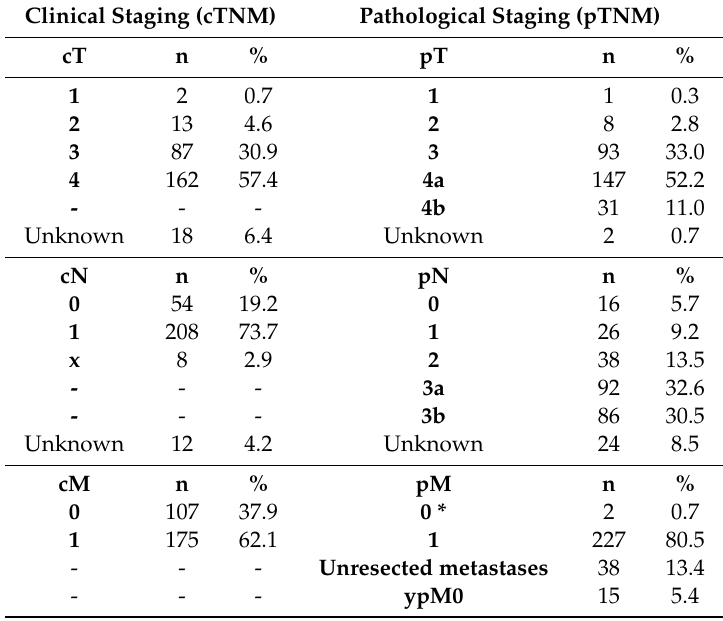
Table 1. Overall population characteristics: clinical and pathological TNM. Clinical Staging (cTNM)